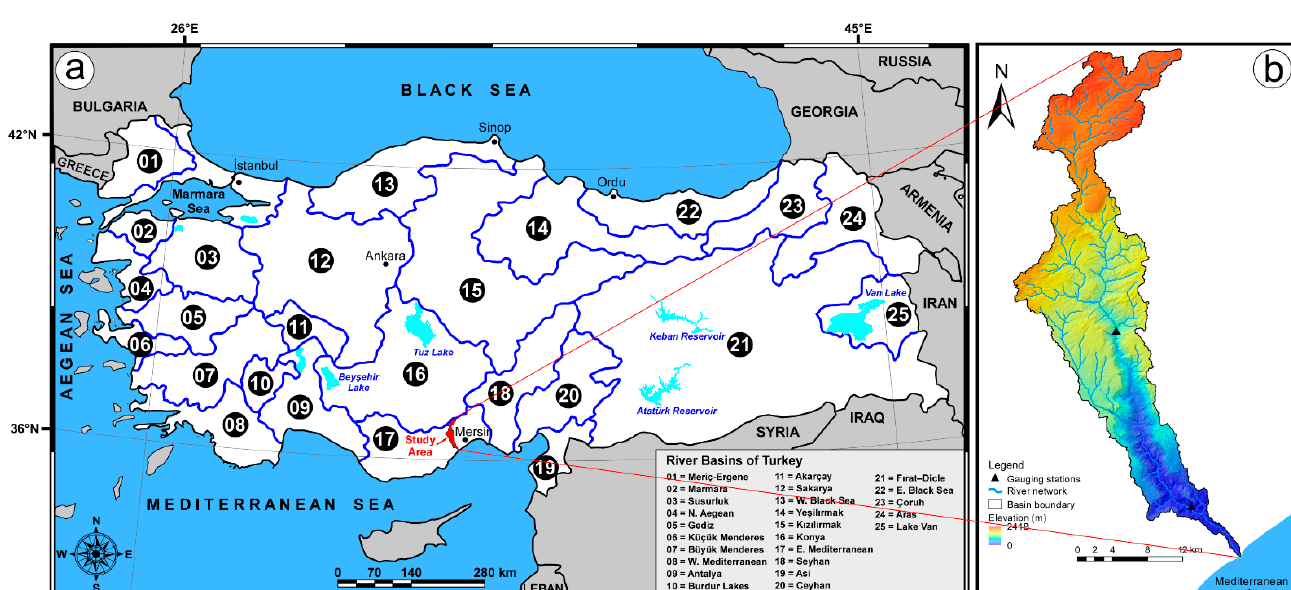
Figure 1. ( a ) The 25 major river basins (blue lines) of Turkey (modified from [49]), where the location of the study area is shown in red colour; and ( b ) the extent of the Alata River Basin (in Mersin) and the location of the gauging stations.